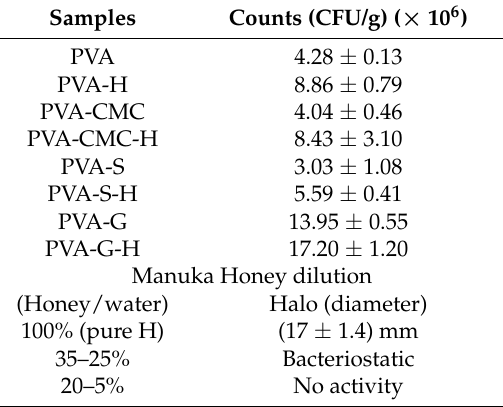
Table 7. Antimicrobial analysis regarding the samples and manuka honey